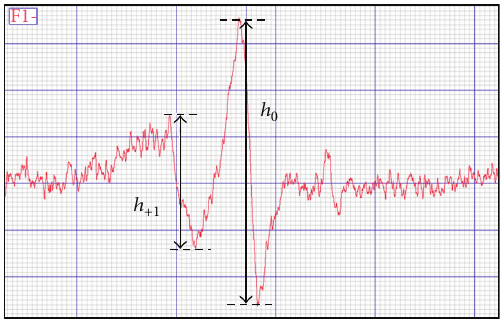
Figure 4: ESR spectrum of erythrocyte membrane proteins labeled with MSL. Measurement parameters: center field: 3473 G, fre- quency: 9.74 GHz, microwave power: 10mW, and sweep width: 100 G.